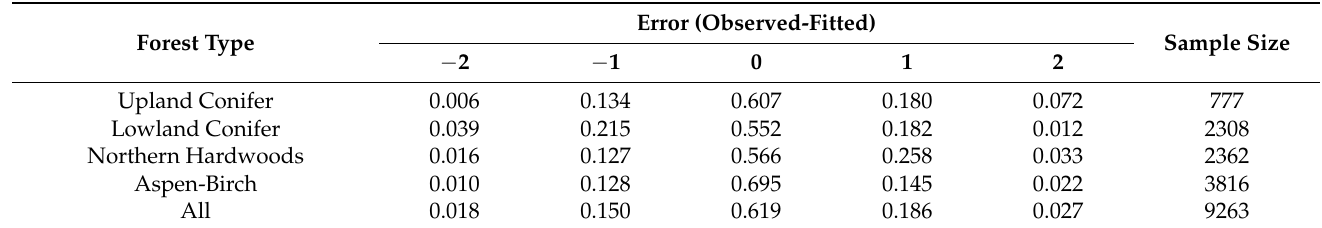
Table 3 breaks down the error by individual forest type/size class